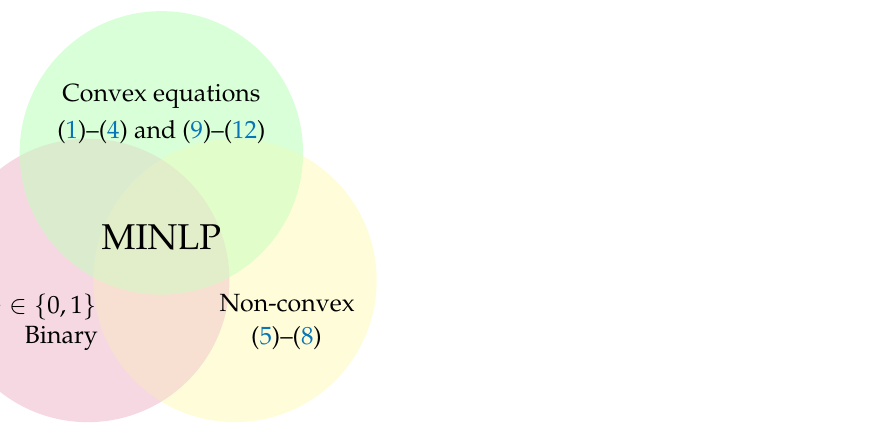
Figure 1. Characterization of the optimization model to locate and size PV sources in radial AC distribution